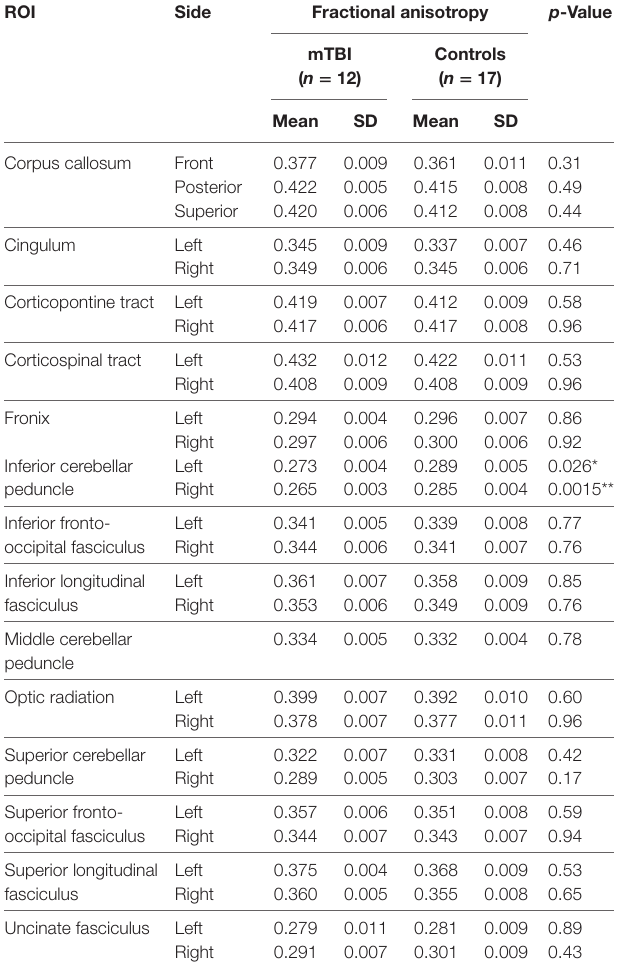
TaBle 2 | Group results for fractional anisotropy (FA) for each